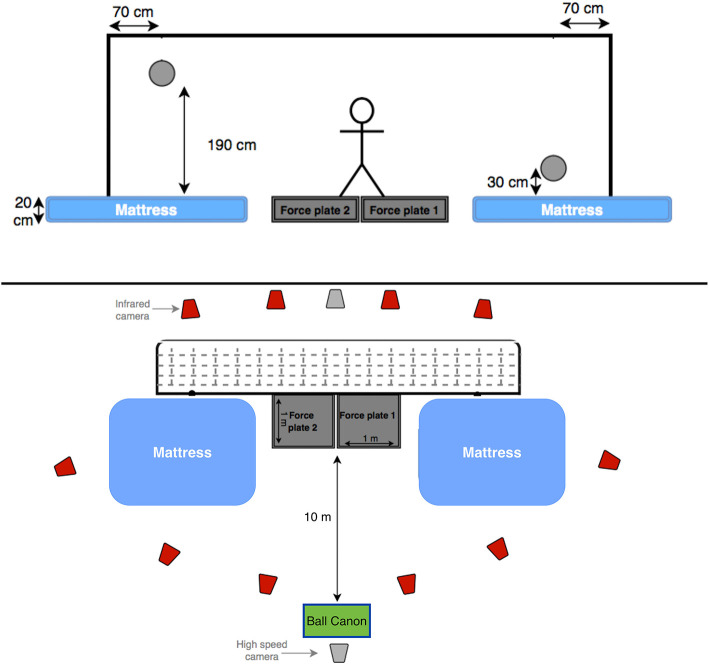
Two schematic diagrams of the experimental set-up (front and top view). The projected positions of the high and low balls are also presented.